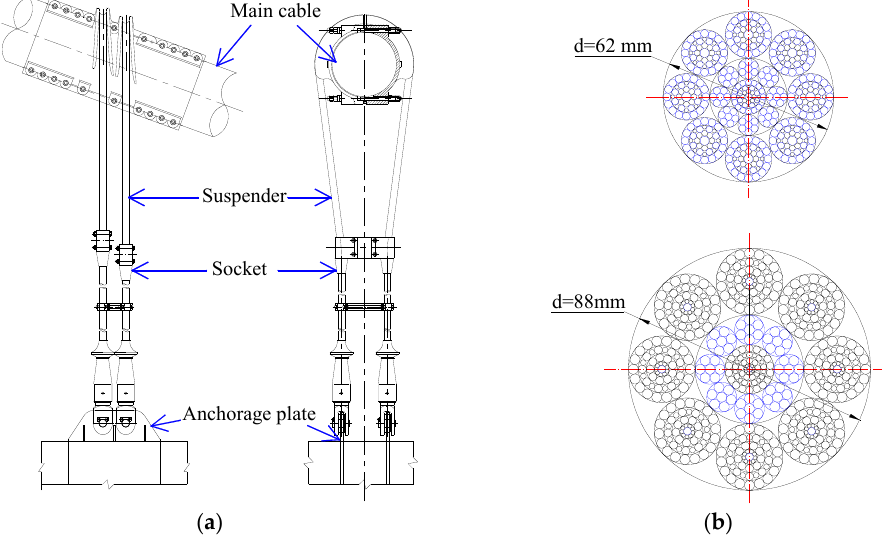
Figure 7. Wire rope suspenders ( a ) configuration and ( b ) cross sections.